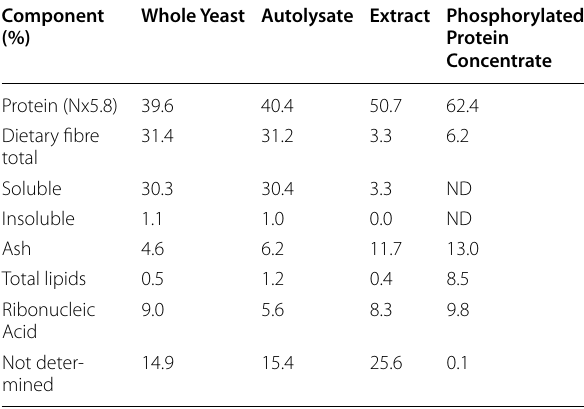
Table 2 Centesimal composition of Saccharomyces cerevisiae yeast